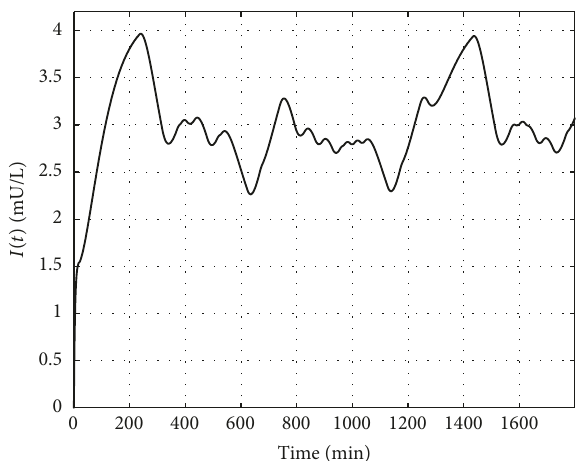
Figure 9: Variation of the blood insulin level over time.